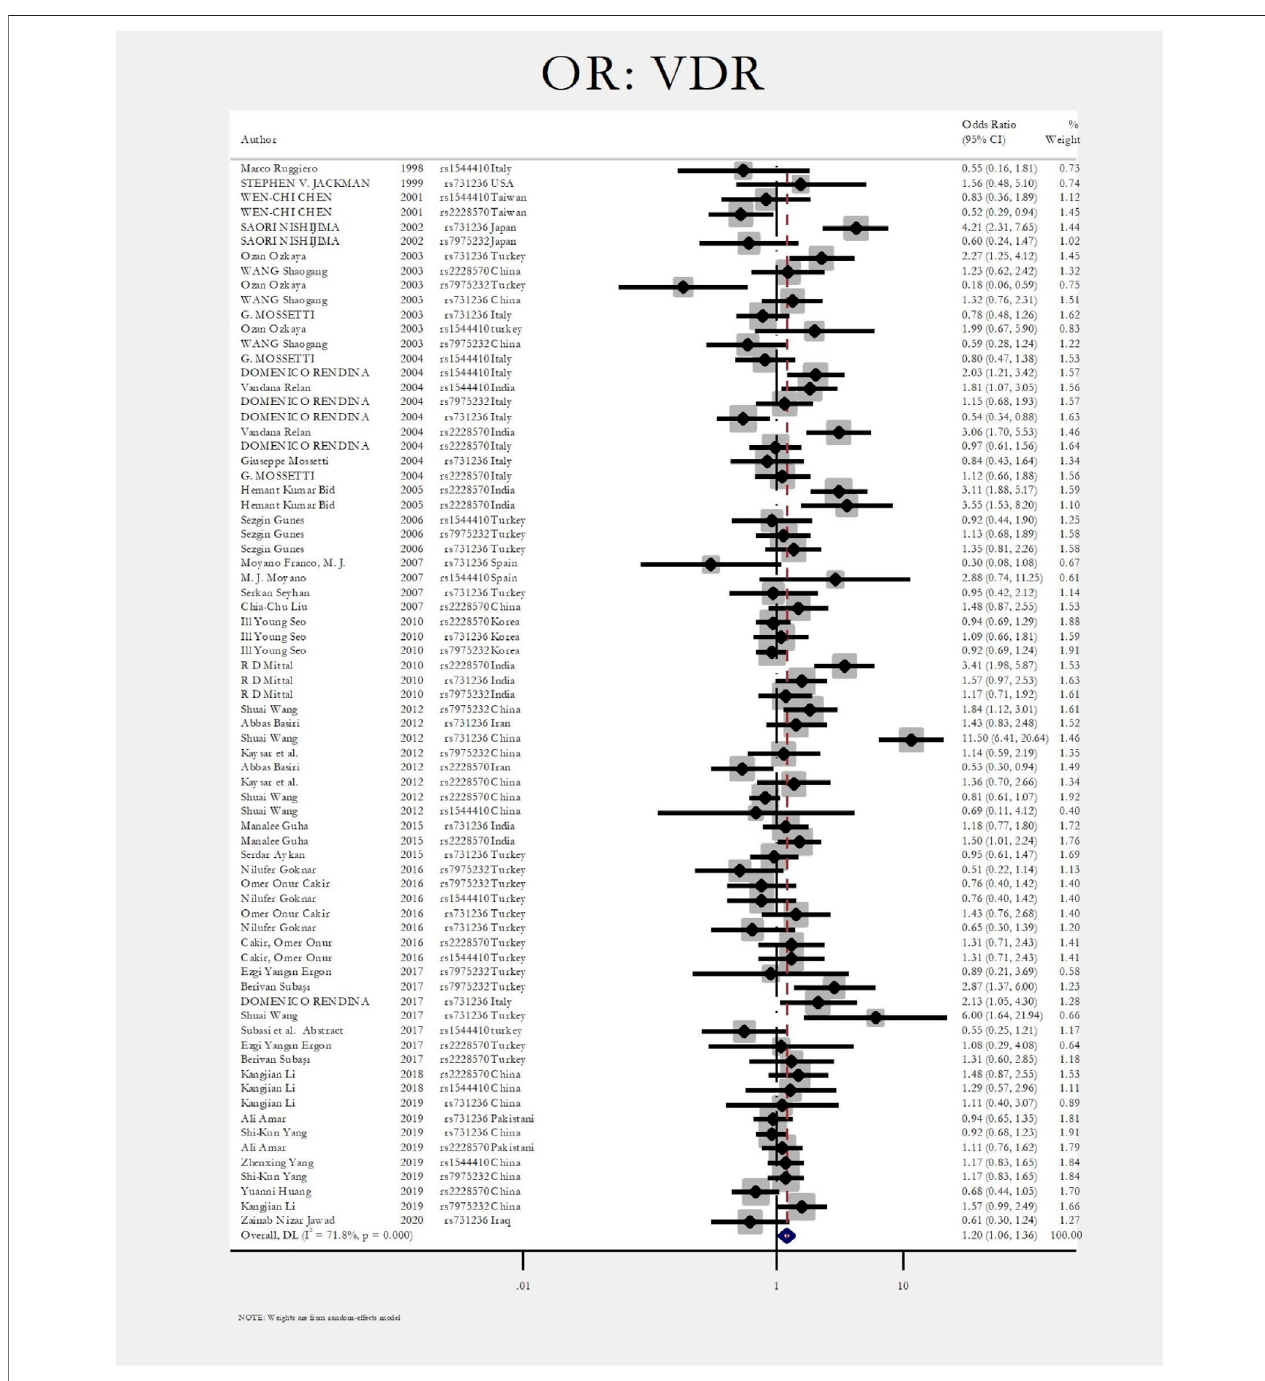
FIGURE 2 | Forest plot: OR for